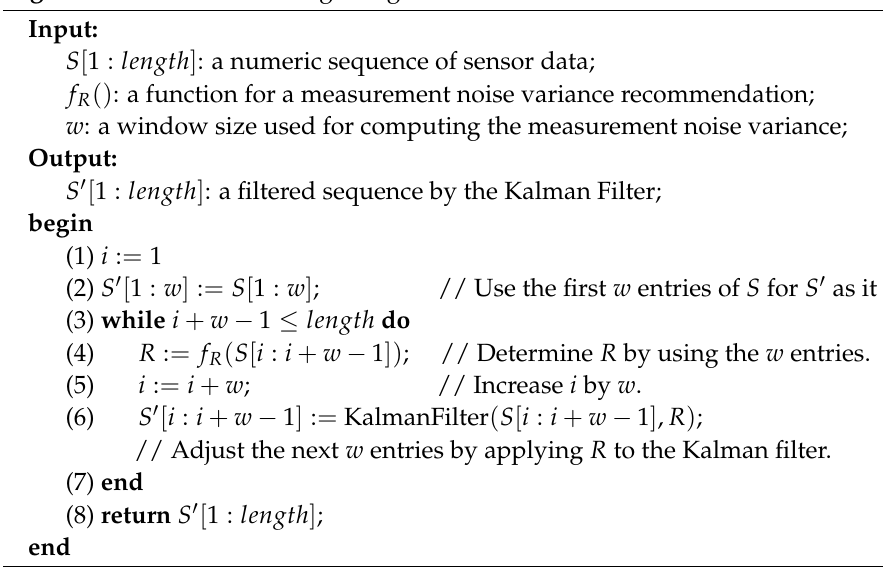
Algorithm 1 Kalman filtering using the recommended measurement noise